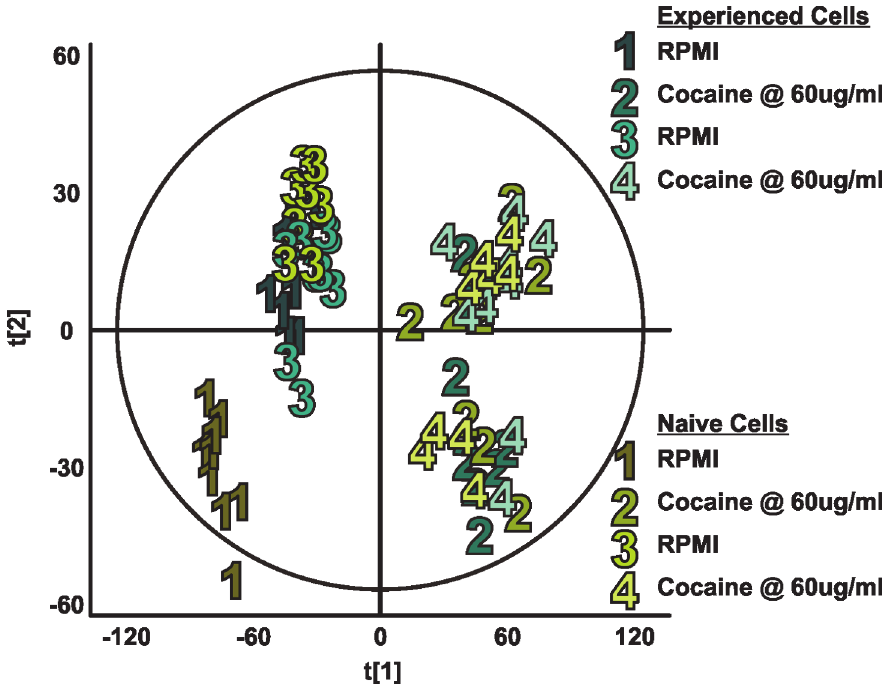
Fig 9. Exometabolomic profiles of na ï ve and cocaine-experienced Jurkat T cells from in-culture analysis. Walking principal component analysis of exometabolomic profiles of na ï ve (shades of yellow) and cocaine-experienced (shades of turquoise) Jurkat T cells using in-culture analysis. Each numerically labeled data point represents the end point of a 54-minute exposure to the indicated media. As with the online experiment, during steps 1 and 3 both cell populations received plain RPMI, while during steps 2 and 4 both received cocaine in RPMI at 60 μ g/mL. Variance between steps 1 and 3 and steps 2 and 4 results in unsupervised grouping according to media exposure type. Separation between na ï ve and experienced cell groups, particularly when under cocaine exposure, does not occur to the same degree, as yellow and turquoise points corresponding to steps 2 and 4 are heavily